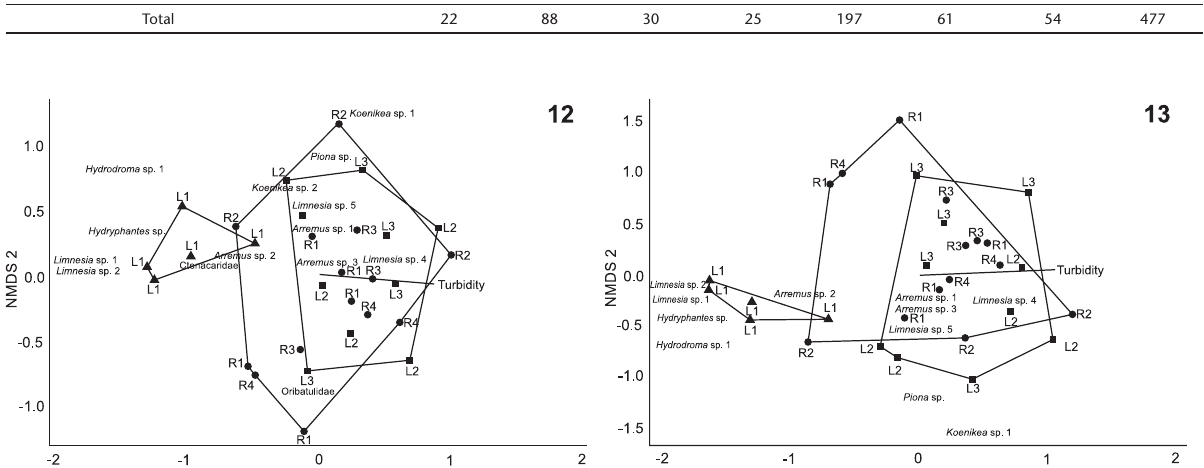
Figures 12–13. Ordination diagram (first two axes) of Non-Metric Multidimensional Scaling (NMDS) using (12) Bray-Curtis and (13) Jaccard indexes with Envfit function for the evaluated environments. ( ▲ Lake 1, ■ Lake 2 and 3, ● Rice Area). Stress: 0.15.